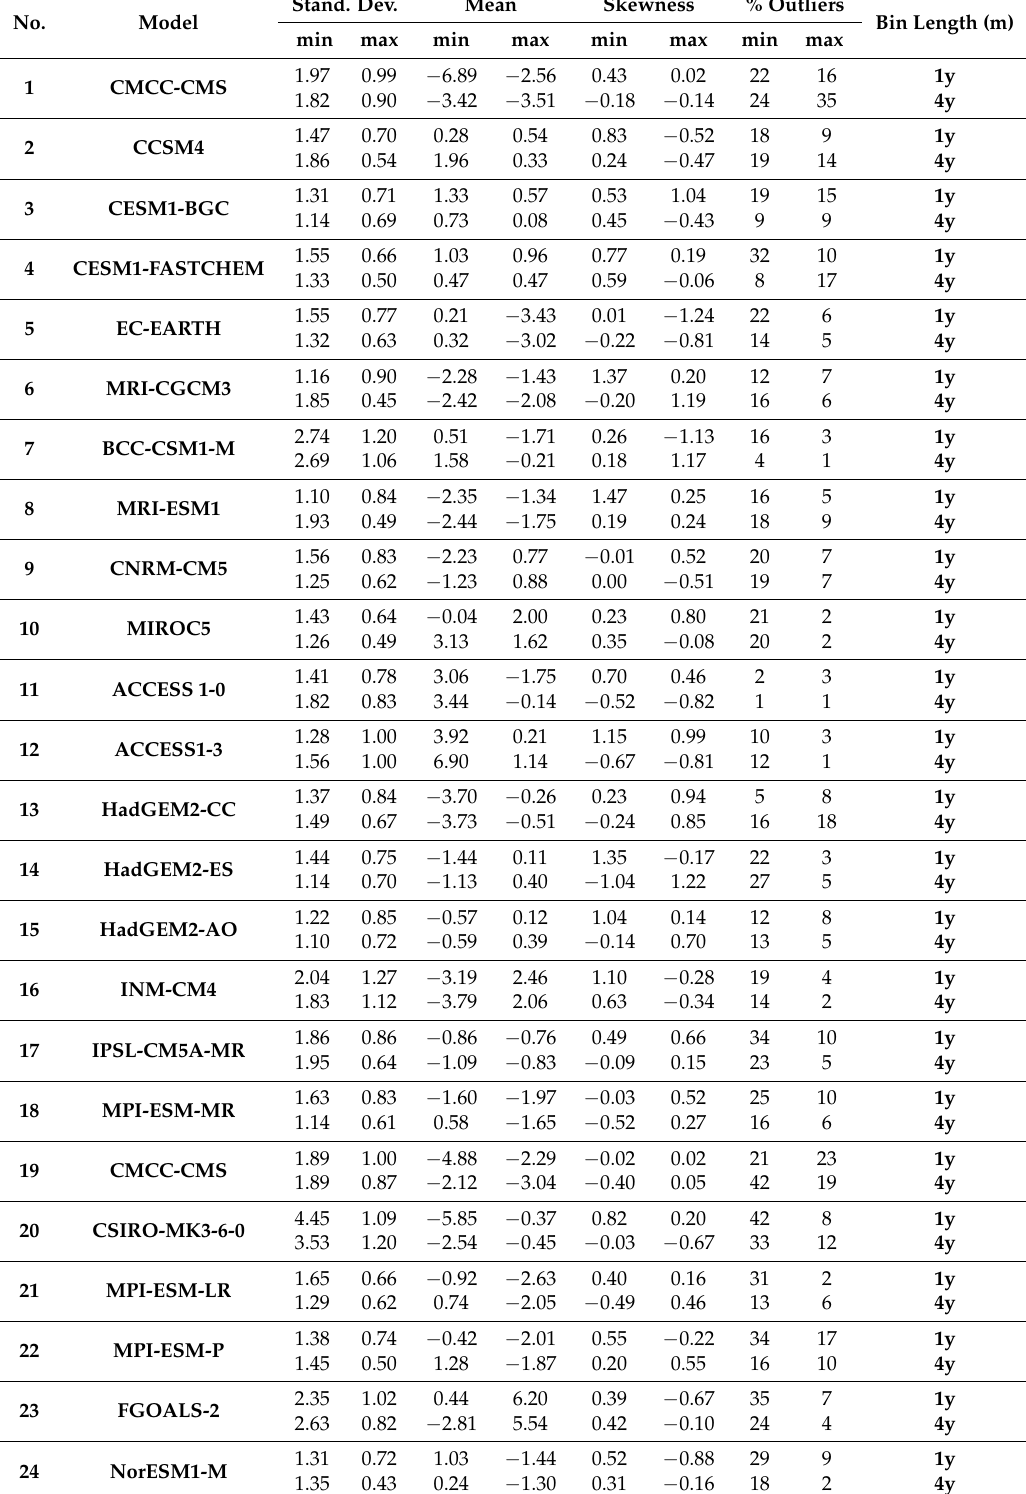
Table 3. Statistical information extracted from the box plots of the biases (Figure 3) in hot and cold temperature extremes between models and 20CRv2c in 1900–1999 for two different bin lengths: m = 1 year and m = 4